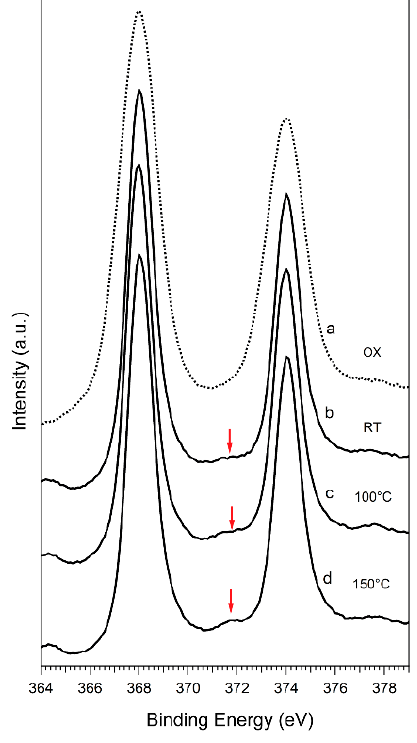
Figure 5. XPS ( a ) Ag 3d core level of bare Ag NPs after air exposure, ( b ) Ag 3d core levels at room temperature (RT), ( c ) Ag 3d core levels at 100 °C and ( d ) Ag 3d core level at 150 °C. The system used was glass/FTO/c ‐ TiO 2 /m ‐ TiO 2 /Ag NPs/MgO. The red arrows highlight the plasmonic features.